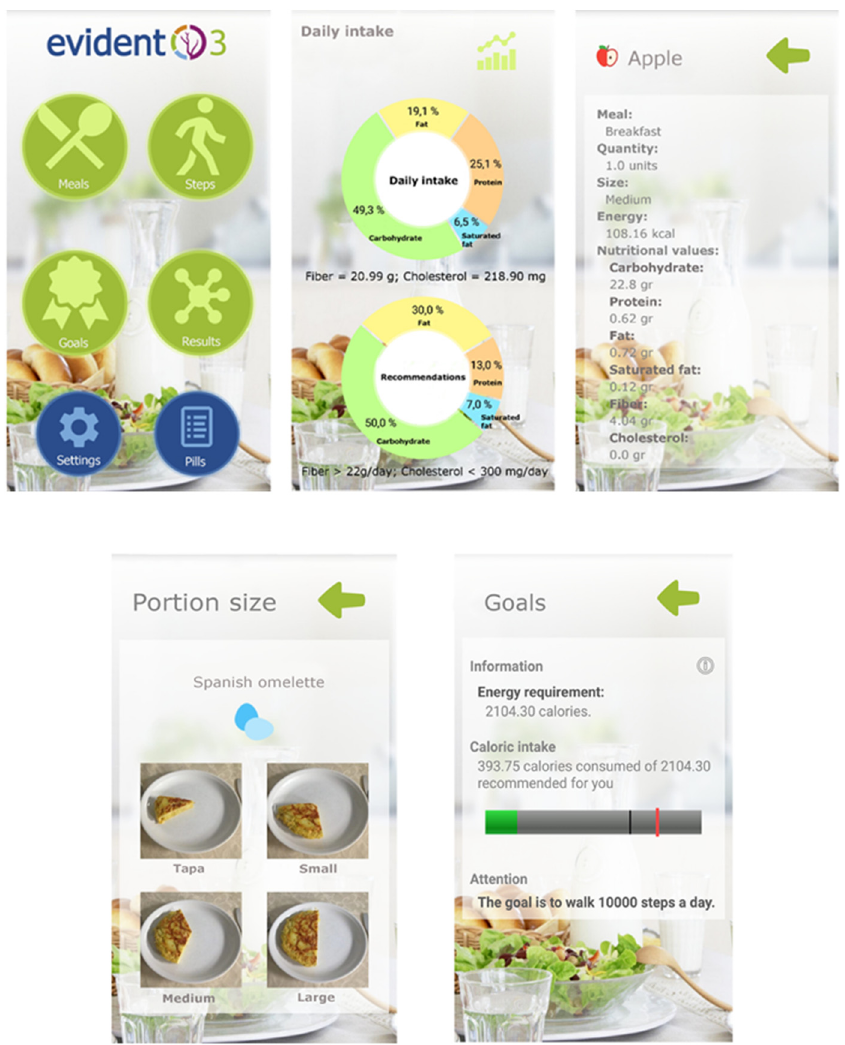
Figure 2. Screenshots of the Evident 3 app.